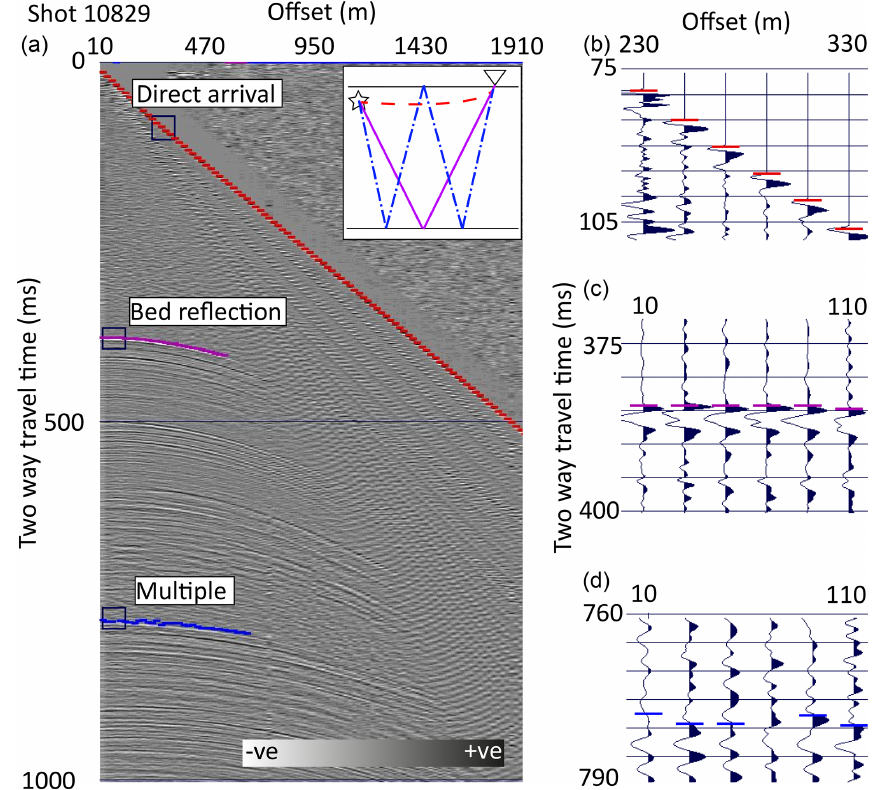
Figure 3. (a) Example shot record from floating portion of line 2 (kilometre 4.8–6.7). (a) Inset shows schematic travel paths for direct (red), primary (purple), and multiple (red) rays. Right-hand panels show wavelets and picks for the direct arrival (b) , primary return (c) , and multiple return (d)